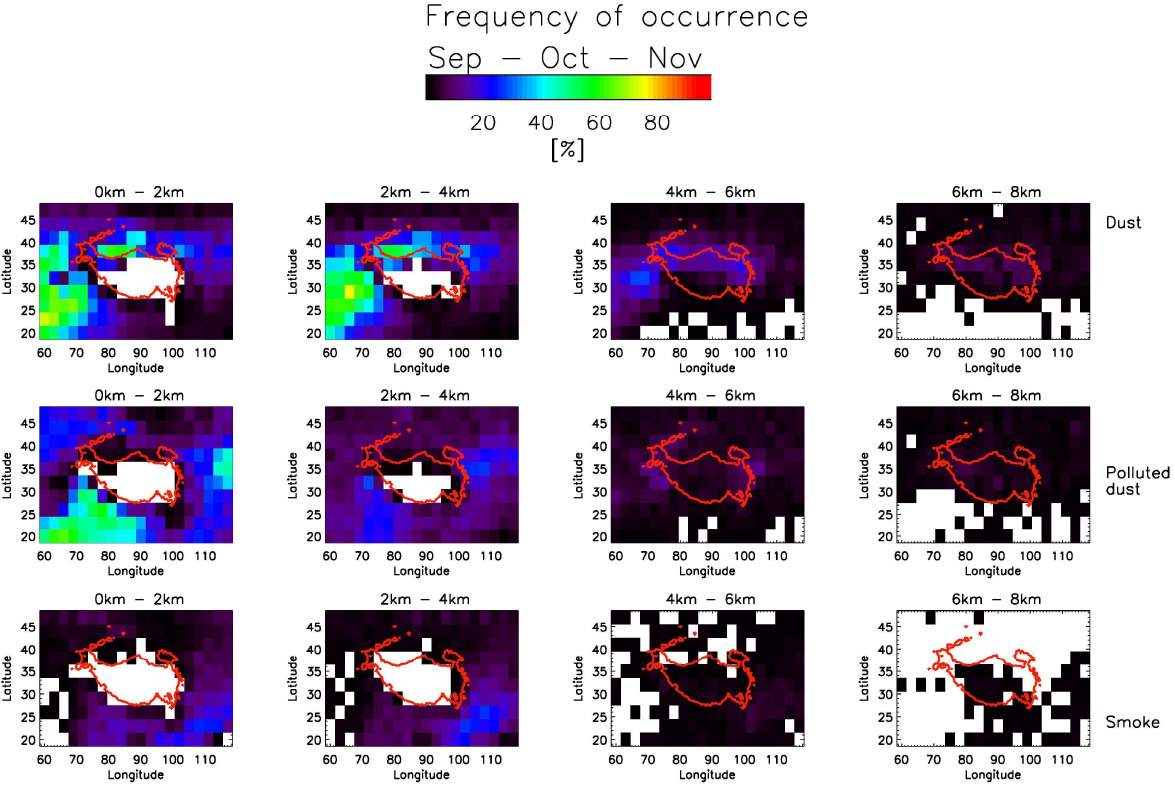
Fig. 4. As Fig. 1 but for SON